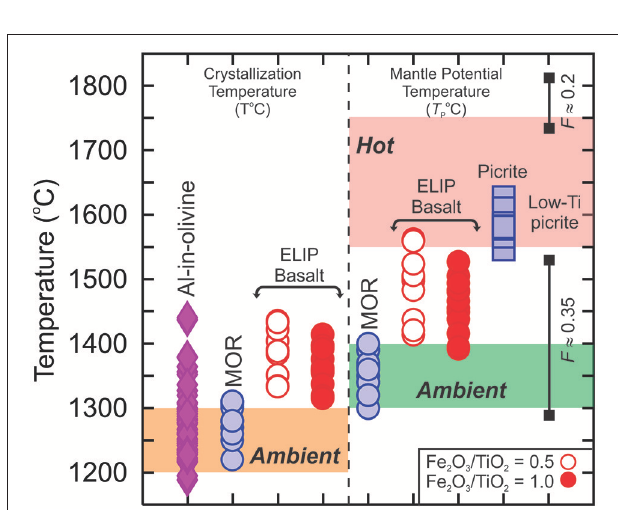
FIGURE 3 | Comparison of crystallization (T ◦ C) and mantle potential temperature ( T ◦ P C) estimates of the ELIP. The results of this study are shown as red circles and white circles with red trim (ELIP basalt). The Al-in-olivine crystallization temperature estimates (diamonds) are for intermediate and low-Ti Emeishan picrite inclusions (Xu and Liu, 2016). The mantle potential temperature estimates of picrite T P (squares) are estimated using PRIMELT2 (He et al., 2010). The olivine-liquid T P (vertical black lines) estimates for low-Ti Emeishan picrite using melt fractions of ( F ) of ≈ 0.35 and ≈ 0.2 (Tao et al., 2015). Crystallization and mantle potential temperature estimates (blue circles) of mid-ocean ridge (MOR) basalt are also shown (Shellnutt and Hsieh, 2016).